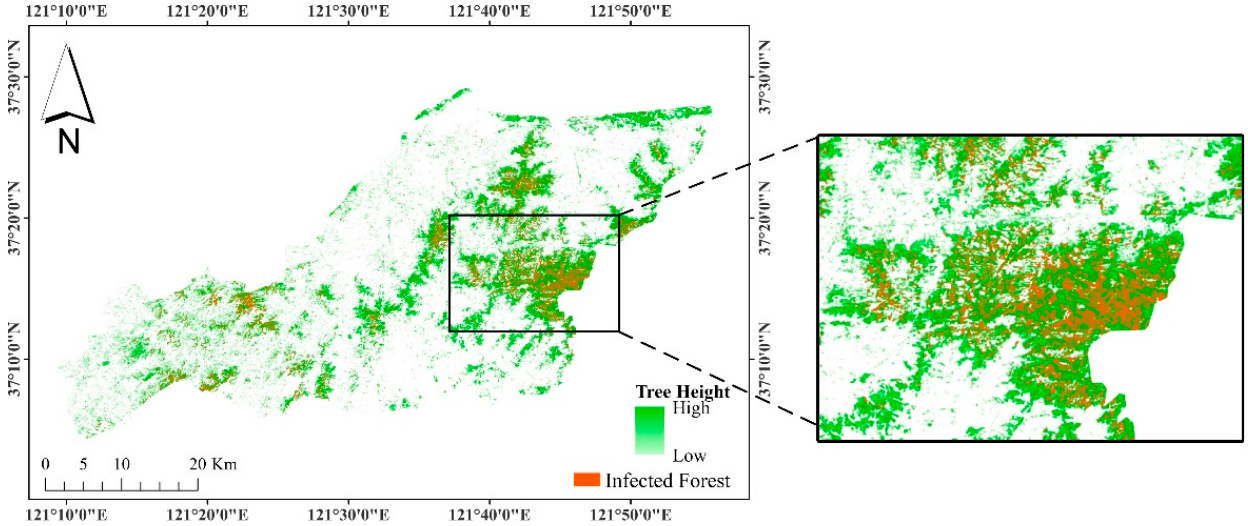
Figure 7. Predicted PWN infestation map from Sentinel-1 image through a random forest algorithm. The background image is a map of tree height.